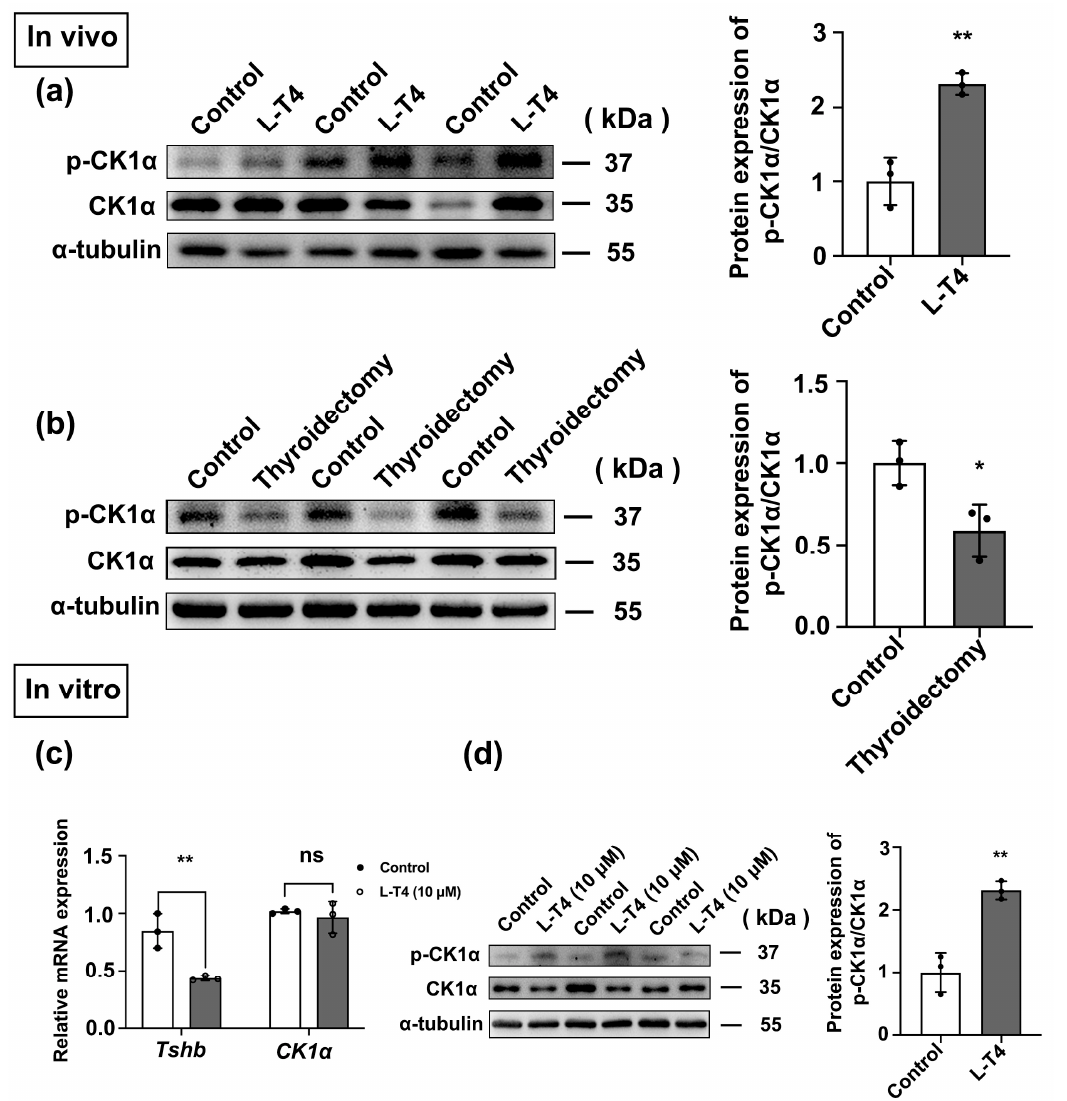
Figure 6. L-T4 enhances the activity of CK1 α . ( a , b ) The expression of p-CK1 α /CK1 α in pituitary tissue was detected using Western blotting after the models of hyperthyroidism and thyroidectomy were established. The protein bands were normalized to CK1 α . * p < 0.05 and ** p < 0.01; n = 3. ( c ) After primary pituitary cells were treated with L-T4 in vitro, Tshb mRNA expression was detected using RT-PCR. Gapdh was used as the internal reference. ** p < 0.01 and ns = no significant, n = 3. ( d ) In primary cultured mouse adenohypophysis cells, Western blotting was used to measure the effect of L-T4 on the expression of p-CK1 α /CK1 α . Western blotting bands were normalized to those of CK1 α . ** p < 0.01; n = 3.